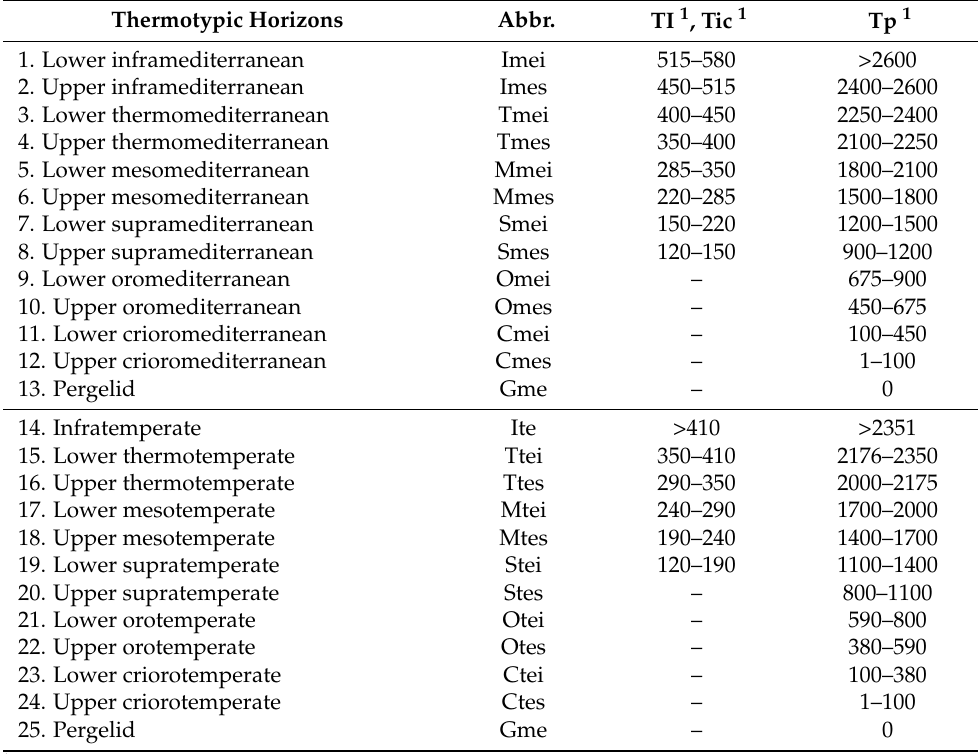
Table 3. Thermotypic horizons, to Mediterranean and temperate macrobioclimates. Tp is only used if CI ≥ 21, or TI, TIc < 120, according to Rivas-Mart í nez et al. [23] (Adapted with permission from Andrade and Contente